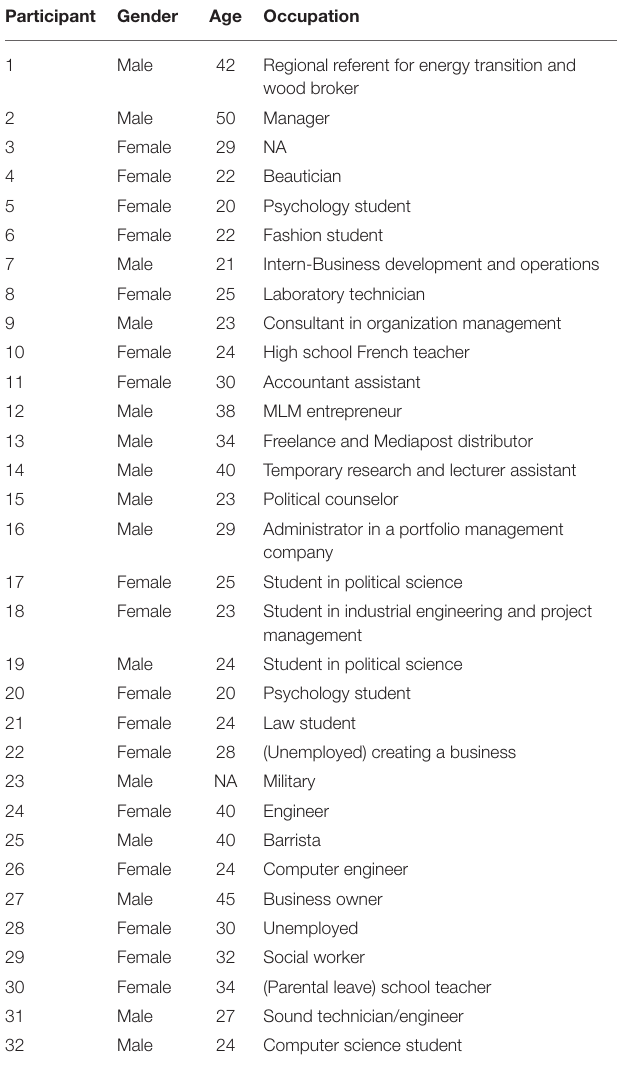
TABLE 1 | Socio-demographic information of participants.